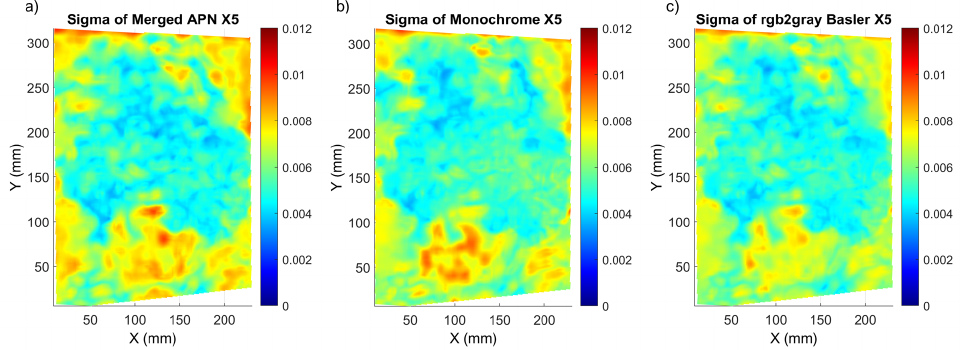
Figure 6. Sigma distribution for the Flower painting corresponding to the X5 shift for the ( a ) merged APN, ( b ) Monochrome and ( c ) rgb2gray Basler